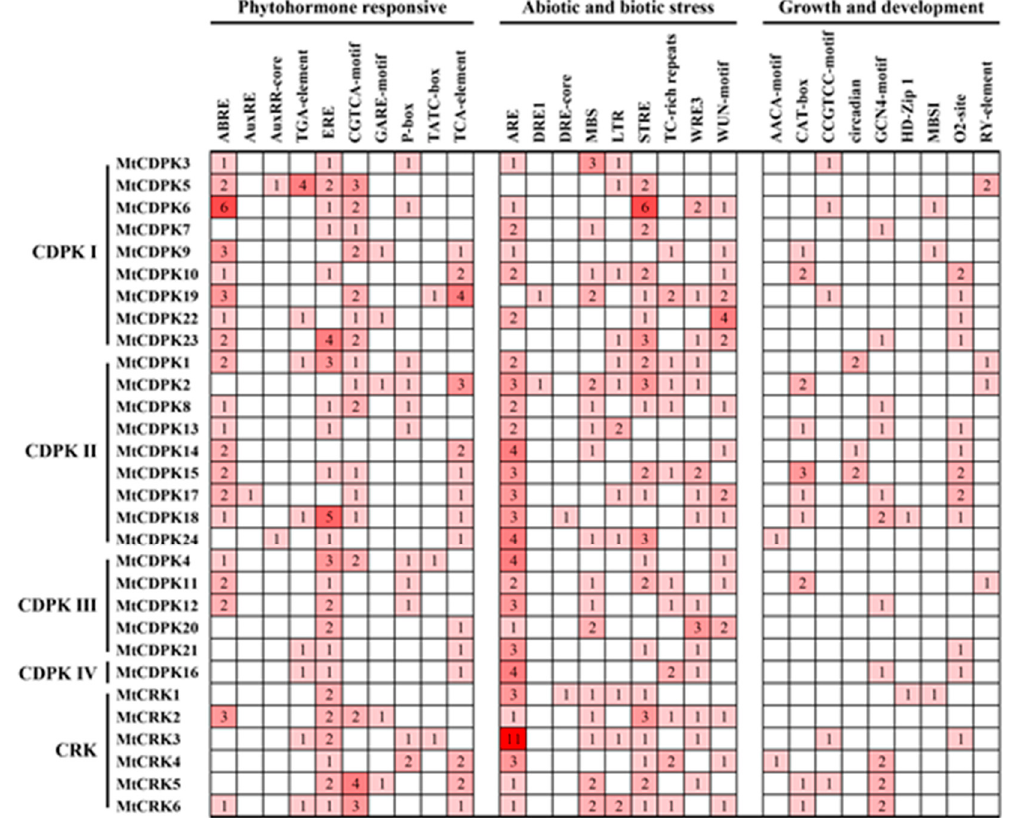
Figure 4. Cis -acting regulatory elements in the promoter region of MtCDPK and MtCRK genes. According to the function annotation, the elements were divided into the following three main categories: phytohormone responsive, abiotic and biotic stresses, and plant growth and development. The numbers and the depth of red represent the frequency of the elements that occur in the promoter region.